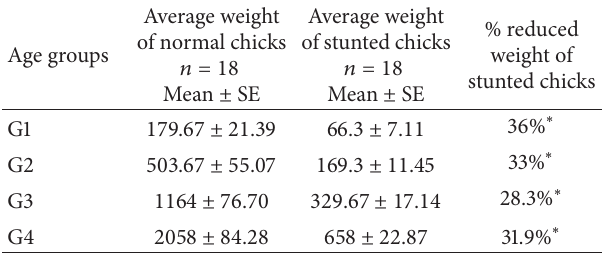
Table 2: % Reduced weights of stunted samples.